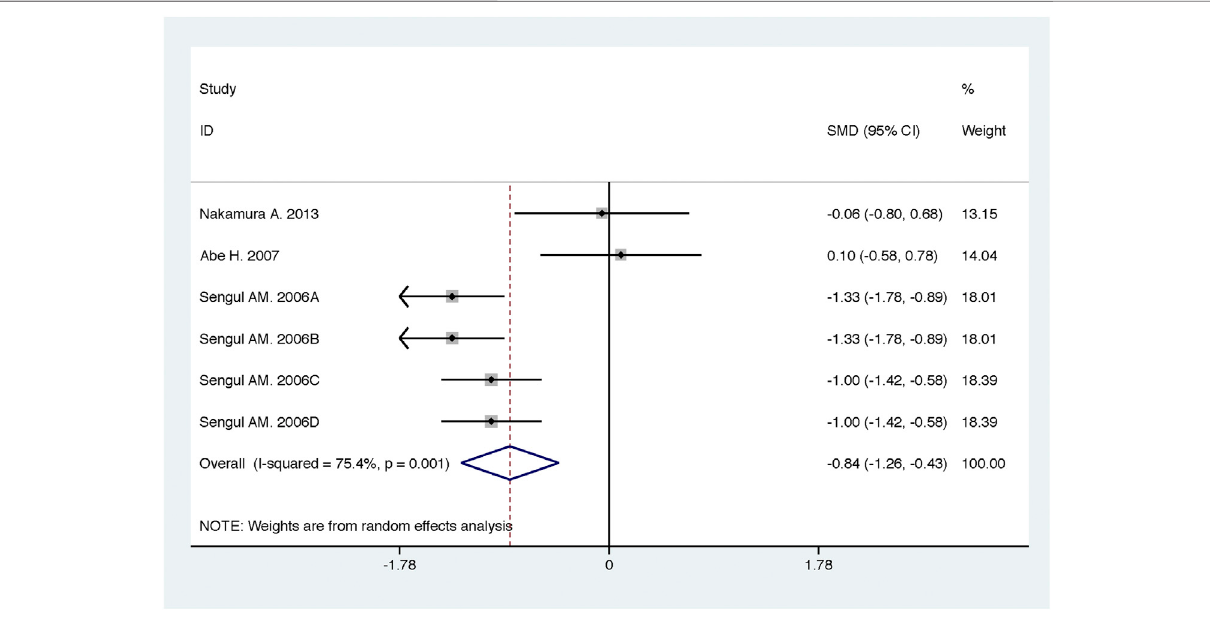
FIGURE 8 | Comparison of ACEI in combination with ARB vs. high-dose ACEI or ARB for urine albumin excretion (g/g of creatinine or g/24 h).